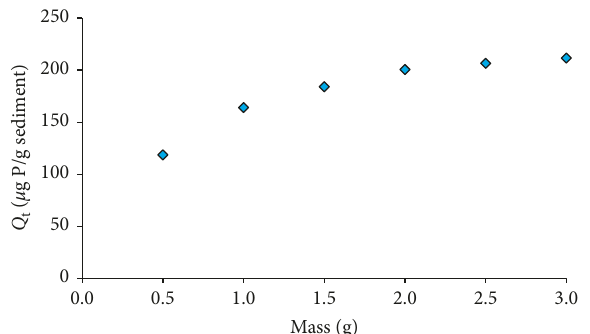
Figure 4: Effect of sediment mass on phosphorus adsorption on Oued Boufekrane sediments at pH � 9.6, V int � 25ml, and phos- phorus concentration � 5mg/L.